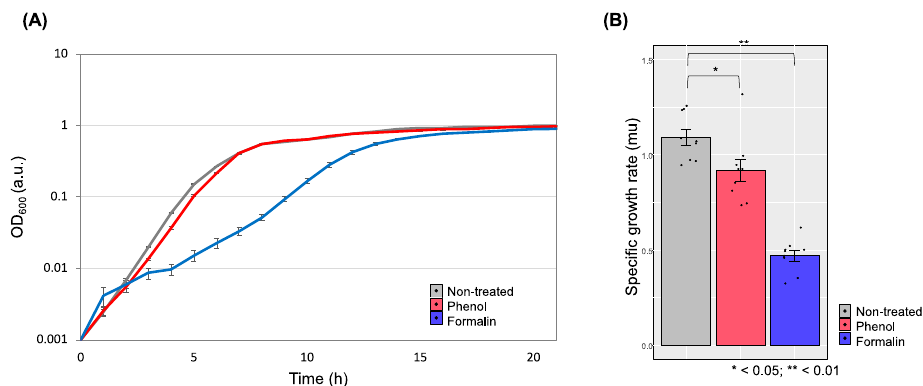
Figure 2. Growth of E. piscicida CK108 in BHI broth with the sub-ICs of phenol and formalin. ( A ) Growth monitoring in a 96-well microplate over time. The optical density (OD 600 nm ) is indicated by log-scale. ( B ) Comparison of specific growth rates at the exponential phase. A total of n = 9 (biological triplicate and technical triplicate) samples were tested. Error bars represent the standard deviation of the mean. Asterisks represent significant differences between the growth conditions as determined by t -tests.